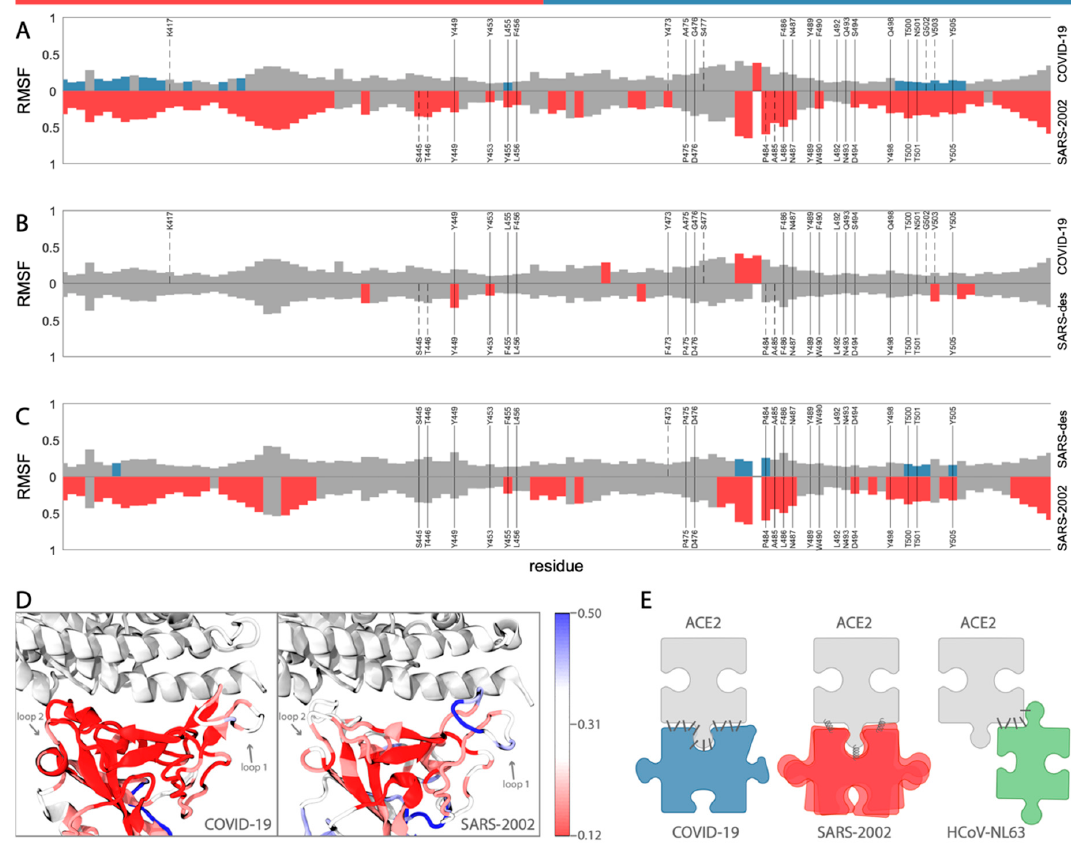
Figure 3. Dynamics of the RBD domains. ( A – C ) The dynamics of COVID-19 and SARS2002, with a comparison to a designed SARS mutant are shown. The graphs show the root-mean-square fluctuation (RMSF) of each residue along the simulation trajectory with respect to the structure with minimum energy. The residue numbers are according to COVID-19 numbering (RefSeq: YP_009724390.1). The top graph ( A ) compares COVID-19 with SARS-2002. The middle graph ( B ) compares COVID-19 with SARS-designed. The bottom graph ( C ) compares SARS-2002 with SARS-designed. For all three graphs, the positions highlighted in red or blue indicate those that have an increase or decrease, respectively, of 50% RMSF with respect to the comparison graph. The contact positions are written in gray, with solid vertical lines denoting the contact residues that exist in both of the comparison structures, and dashed vertical lines denote the contact residues that exist in only one of the comparison structures; ( D ) the RMSF mapped onto the RBD structure (red—more rigid, blue—more flexible); ( E ) the schematic representation of ACE2 binding strategies by COVID-19, SARS-2002, and HCoV-NL63 RBDs.